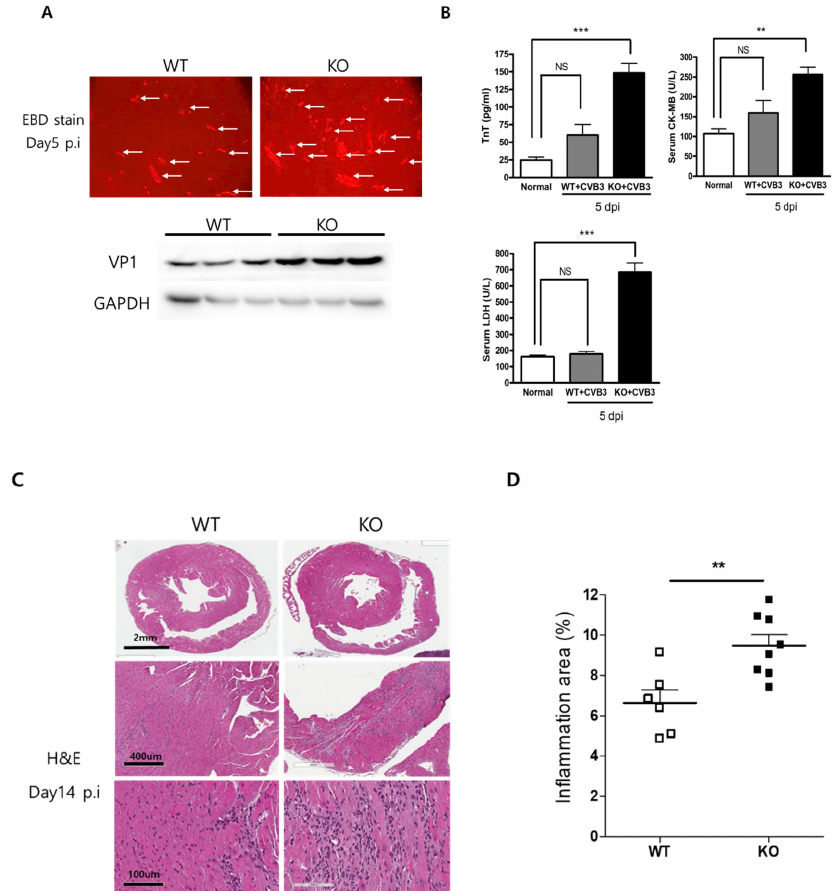
Figure 3. Myocardial damage increased in AKT2 knockout mice. ( A ) WT and KO mice were injected with 10% Evans blue dye (EBD) for 18 h before being sacrificed. Hearts were sectioned and subjected to fluorescence microscopy to determine the red area of EBD uptake (arrow). Heart extracts were subjected to Western blot analysis using the indicated antibodies. ( B ) Molecules indicating muscle damage (TnT, CK-MB, and LDH) were measured in Day 5 p.i mouse sera. ( C ) Histological findings using hematoxylin and eosin (H&E) staining in sectioned hearts showed inflammatory cell infiltration on Day 14 p.i. ( D ) Quantification of the inflamed area (%) of the heart ( n = 4 each group). All data are the means ± s.e.m. ** p < 0.01, and *** p < 0.001 according to a two-tailed Student’s t -test.